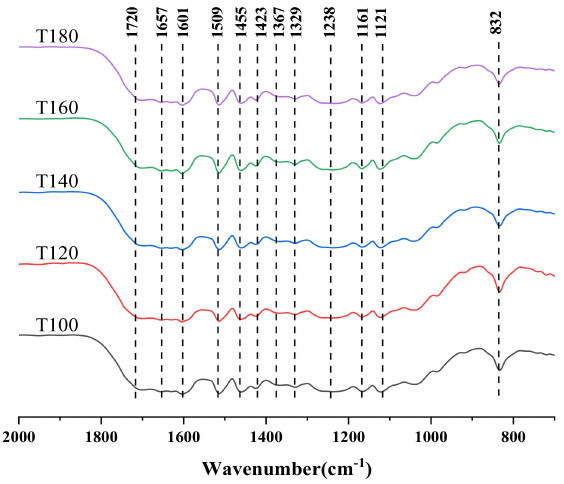
Figure 8. Infrared spectra of lignin obtained by different ultrasonic temperature treatments.